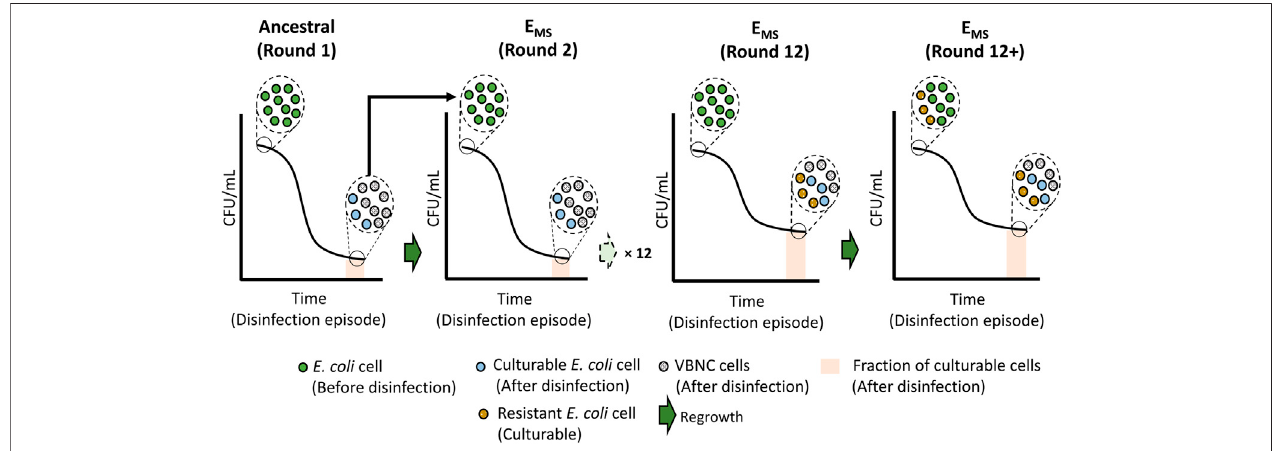
FIGURE 7 | Schematic demonstrating the potential emergence of resistant cells and the shift in the fraction of VBNC and culturable cells post-disinfection in response to multiple rounds of monochloramine disinfection.